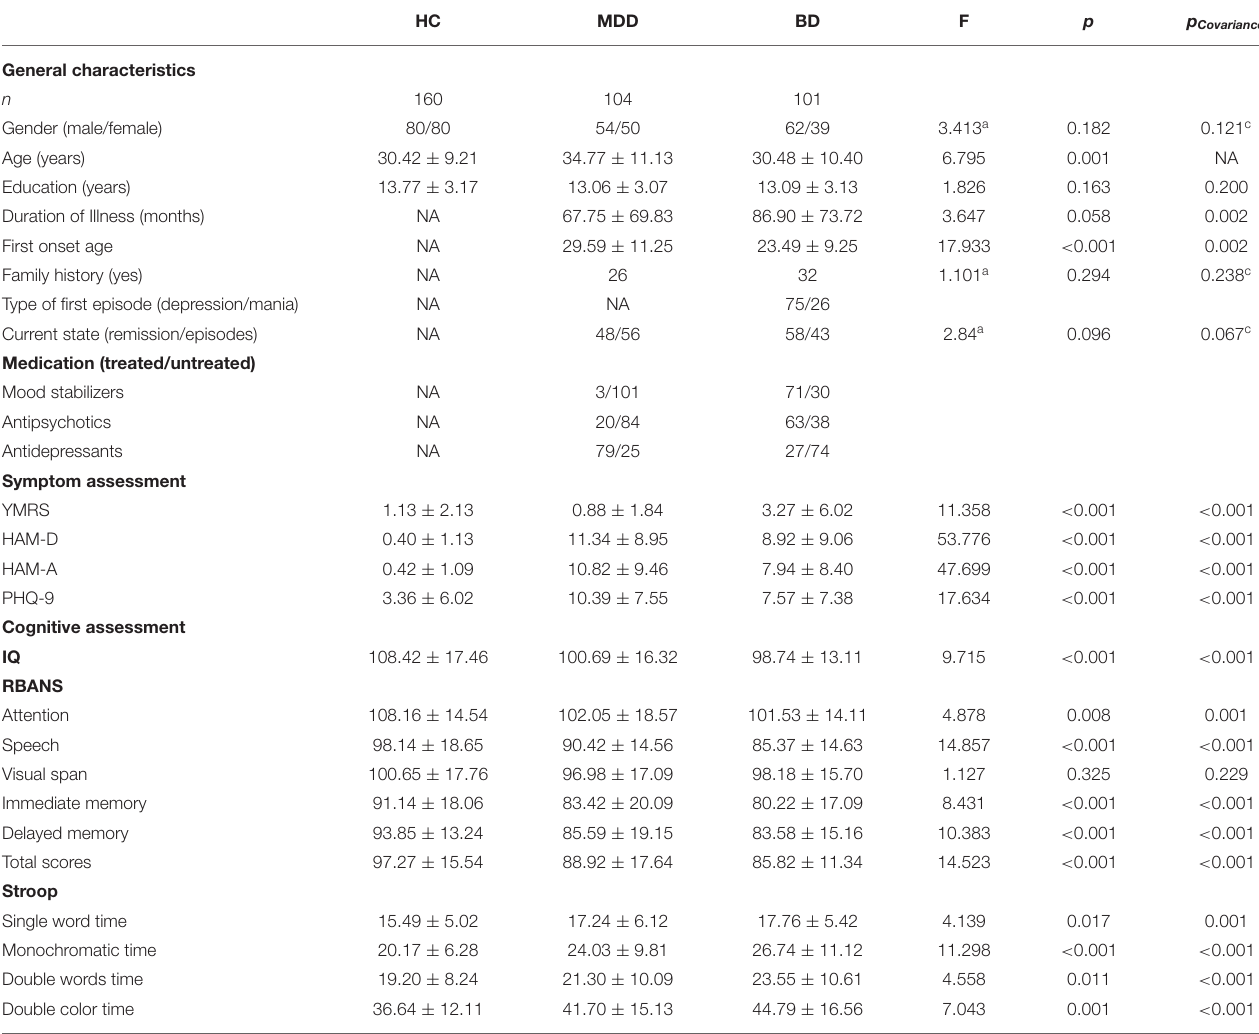
TABLE 1 | Demographics and other characteristics in three groups. HC MDD BD F p p